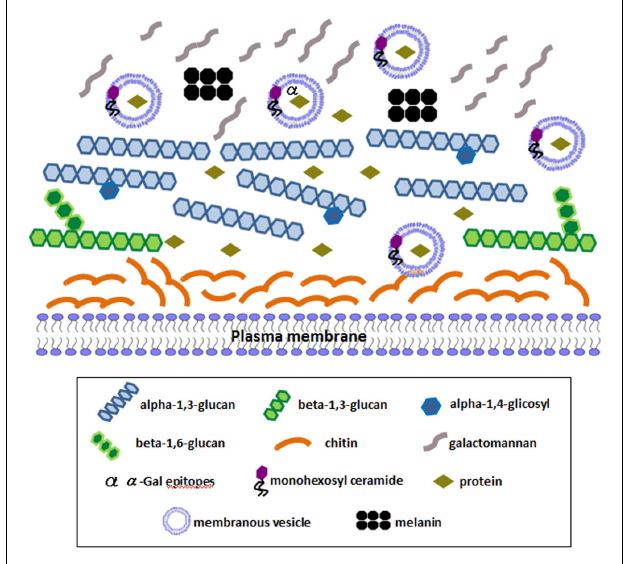
FIGURE 1 | Schematic representation of an updated view of Paracoccidioides yeast phase cell wall components. Structural polysaccharides are represented: an outer layer of alpha-1,3-glucan (with eventual single alpha-1,4-linked glucose residues) in higher amounts than beta-1,3-glucan, which lies in internal layers and is decorated with small beta-1,6-glucan side chains. Internal chitin fibers maintain the round shape and galactomannan composes an external fibrillar layer. Melanin is shown on the surface. Extracellular membranous vesicles containing monohexosyl ceramide transport components outside the plasma membrane, including numerous intracellular proteins. A number of intracellular proteins that have been immunolocalized to the cell wall in yeast cells usingTEM or confocal microscopy (see text) are represented, as well as α -Gal epitopes. Some of them have also been detected in isolated extracellular vesicles, like enolase, GADPH, formamidase, and triosephosphate